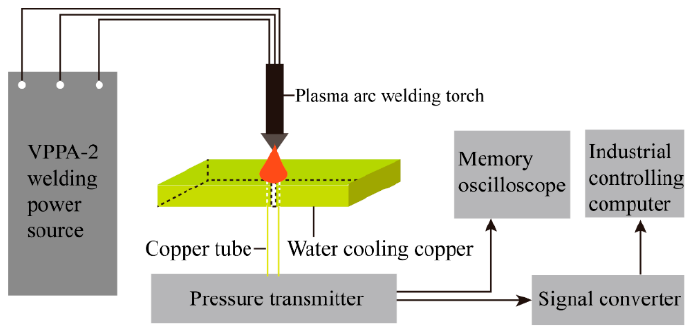
Figure 10. Sketch of plasma arc pressure measure and data acquisition system.